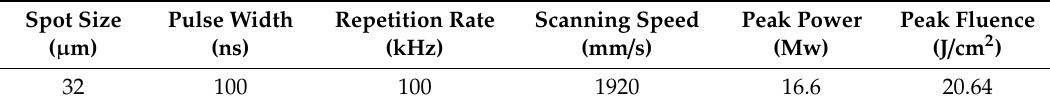
Table 1. Laser parameters for the study of the laser light incident angle’s influence.